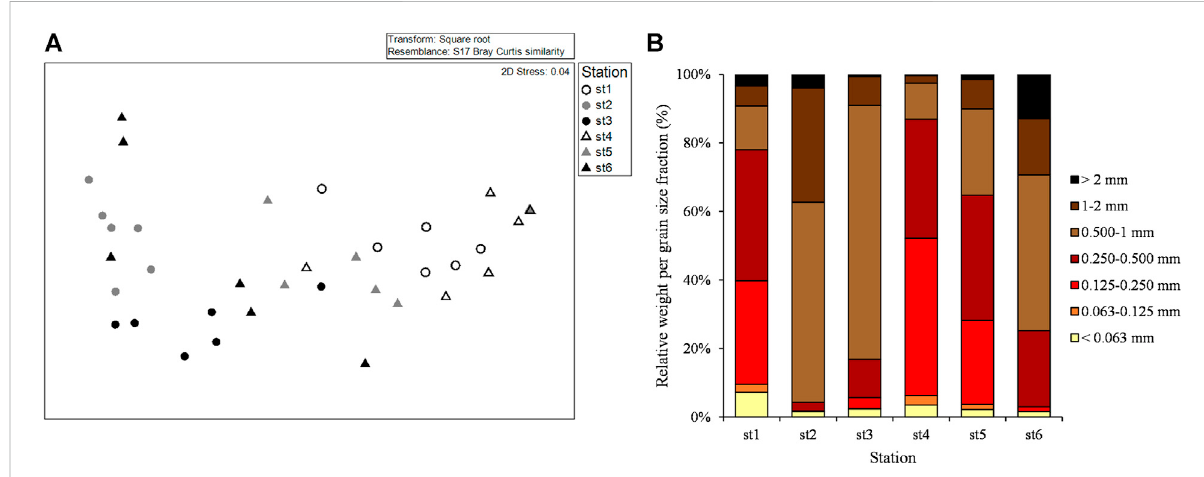
FIGURE 9 Multidimensional scaling plot based on the Bray-Curtis distance between samples of the different stations according to grain size fractions (A) and relative distribution of grain size fractions per station (B) .